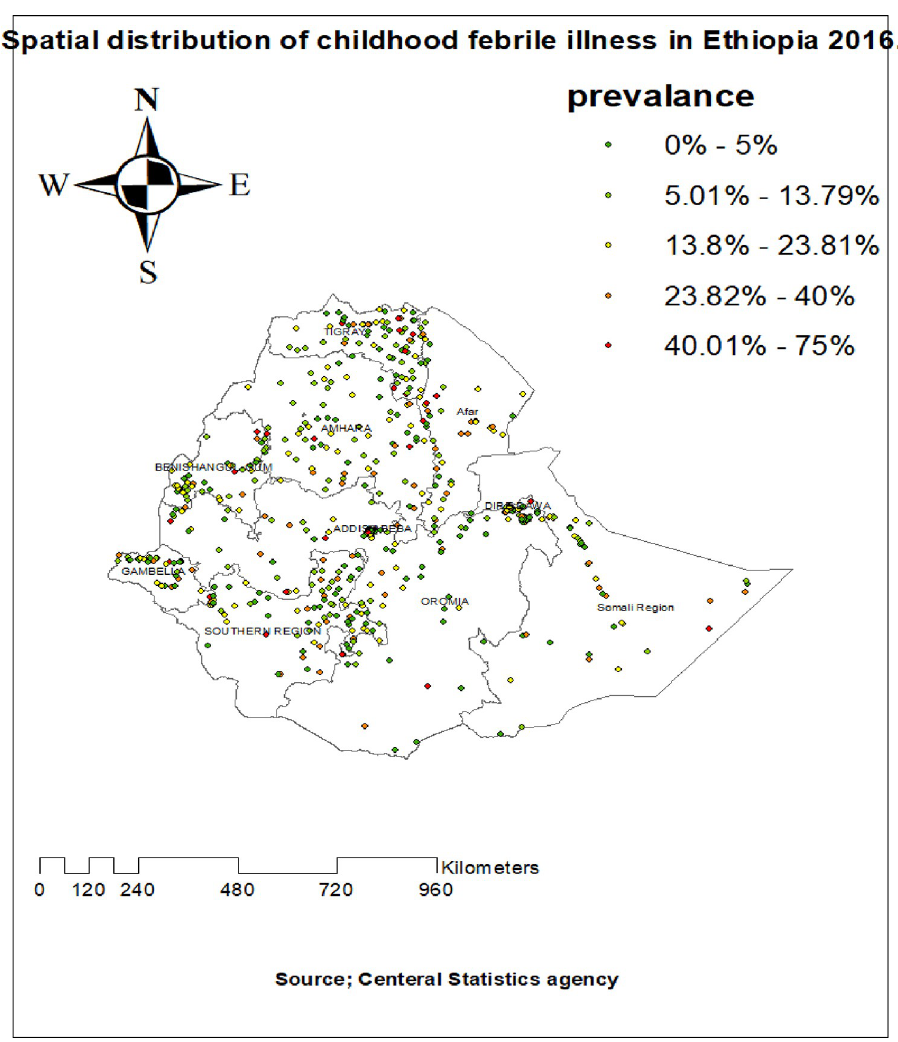
Fig 2. Spatial distribution of febrile illness among under-five children in Ethiopia